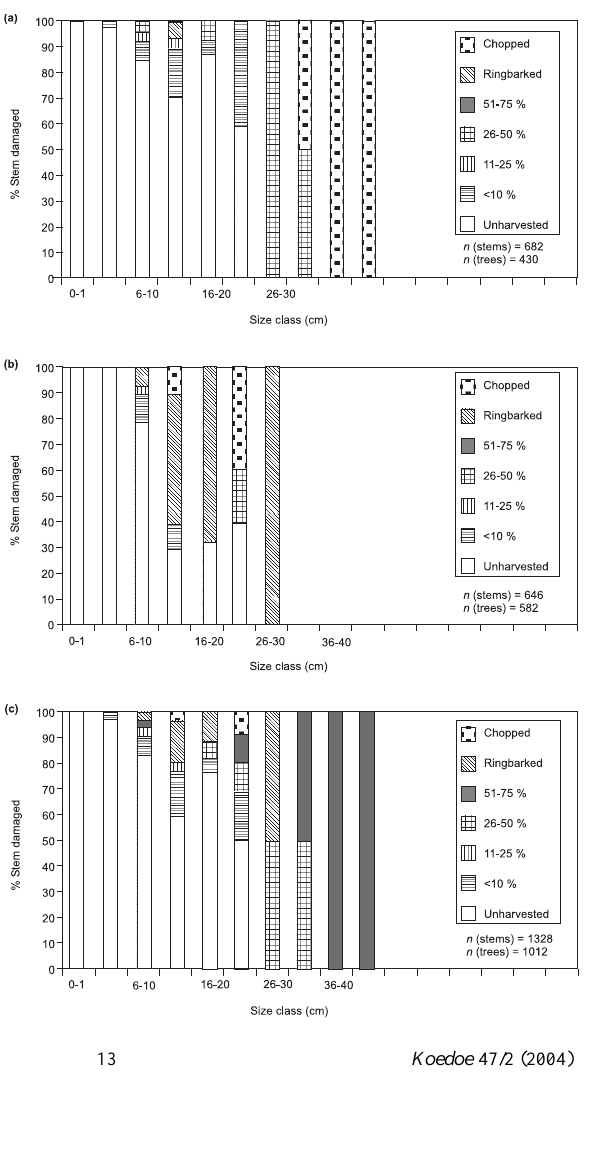
Fig. 6. Degree of stem damage to har- vested Rapanea melanophloeos through harvesting of bark below 2 m on the stem, and chopping of stems in populations located on (a) and (b) a forestry plantation near Barberton and (c) near